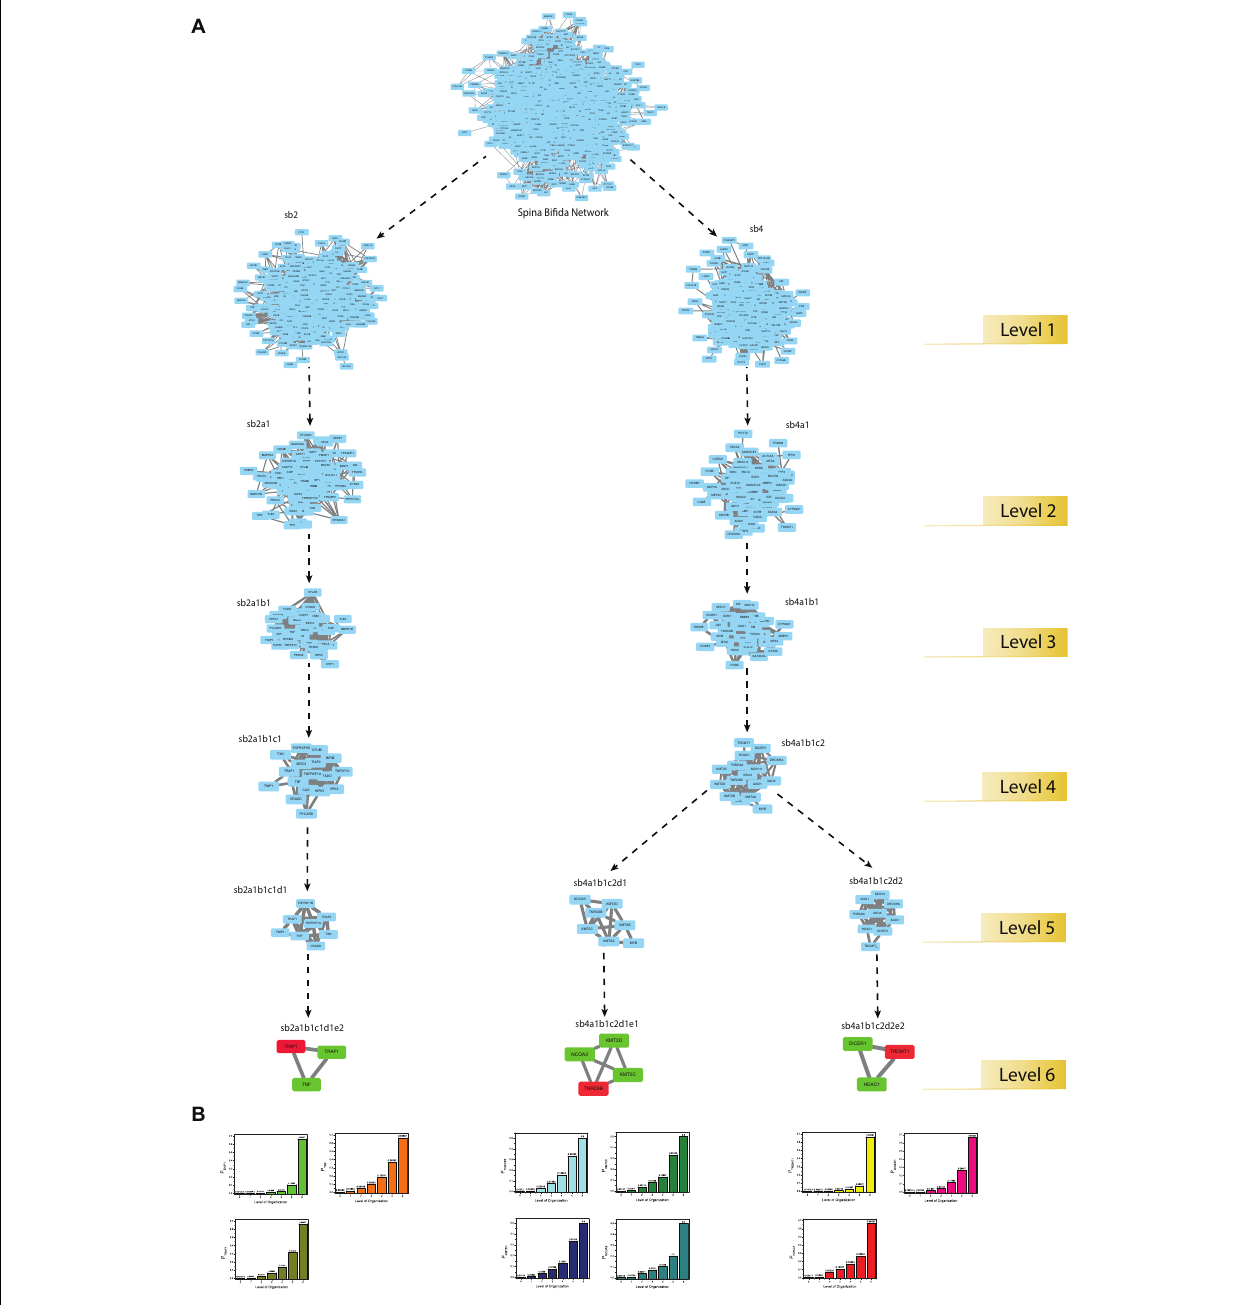
FIGURE 6 | (A) modular path of the KRs starting from the main network to the motif level. The seed-gene-KRs are shown in red and their interacting-partner-KRs are shown in green. (B) KRs probability distribution as a function of levels of the hierarchical organization of the SB network.